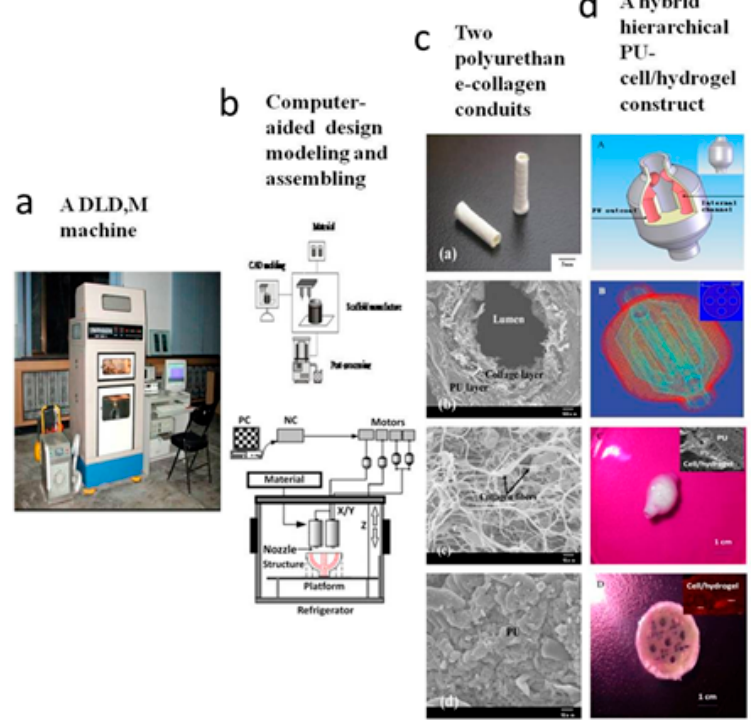
Figure 6. A double-nozzle low-temperature (DLDM) technology developed at Tsinghua University, prof. Wang’ group: ( a ) the DLDM printer; ( b ) schematic description of the working processes of the